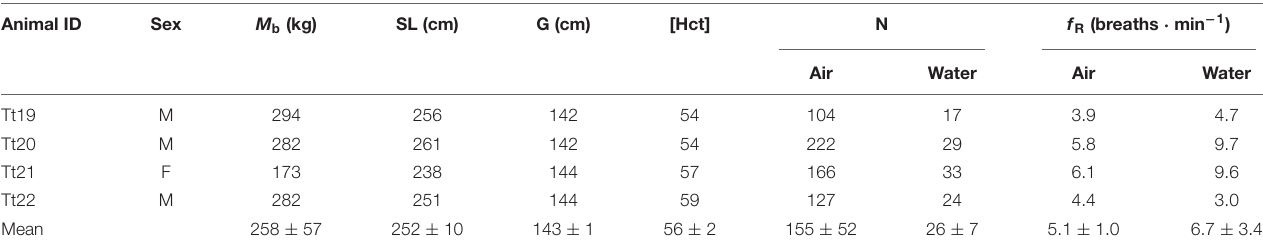
TABLE 1 | Animal identification, sex (M-male, F-female), body mass ( M b ), straight length (SL), maximum girth (G), blood hematocrit concentration (Hct, %), number of breaths collected (N), and breathing frequency ( f R ), while in air or in water. Animal ID Sex M b (kg) SL